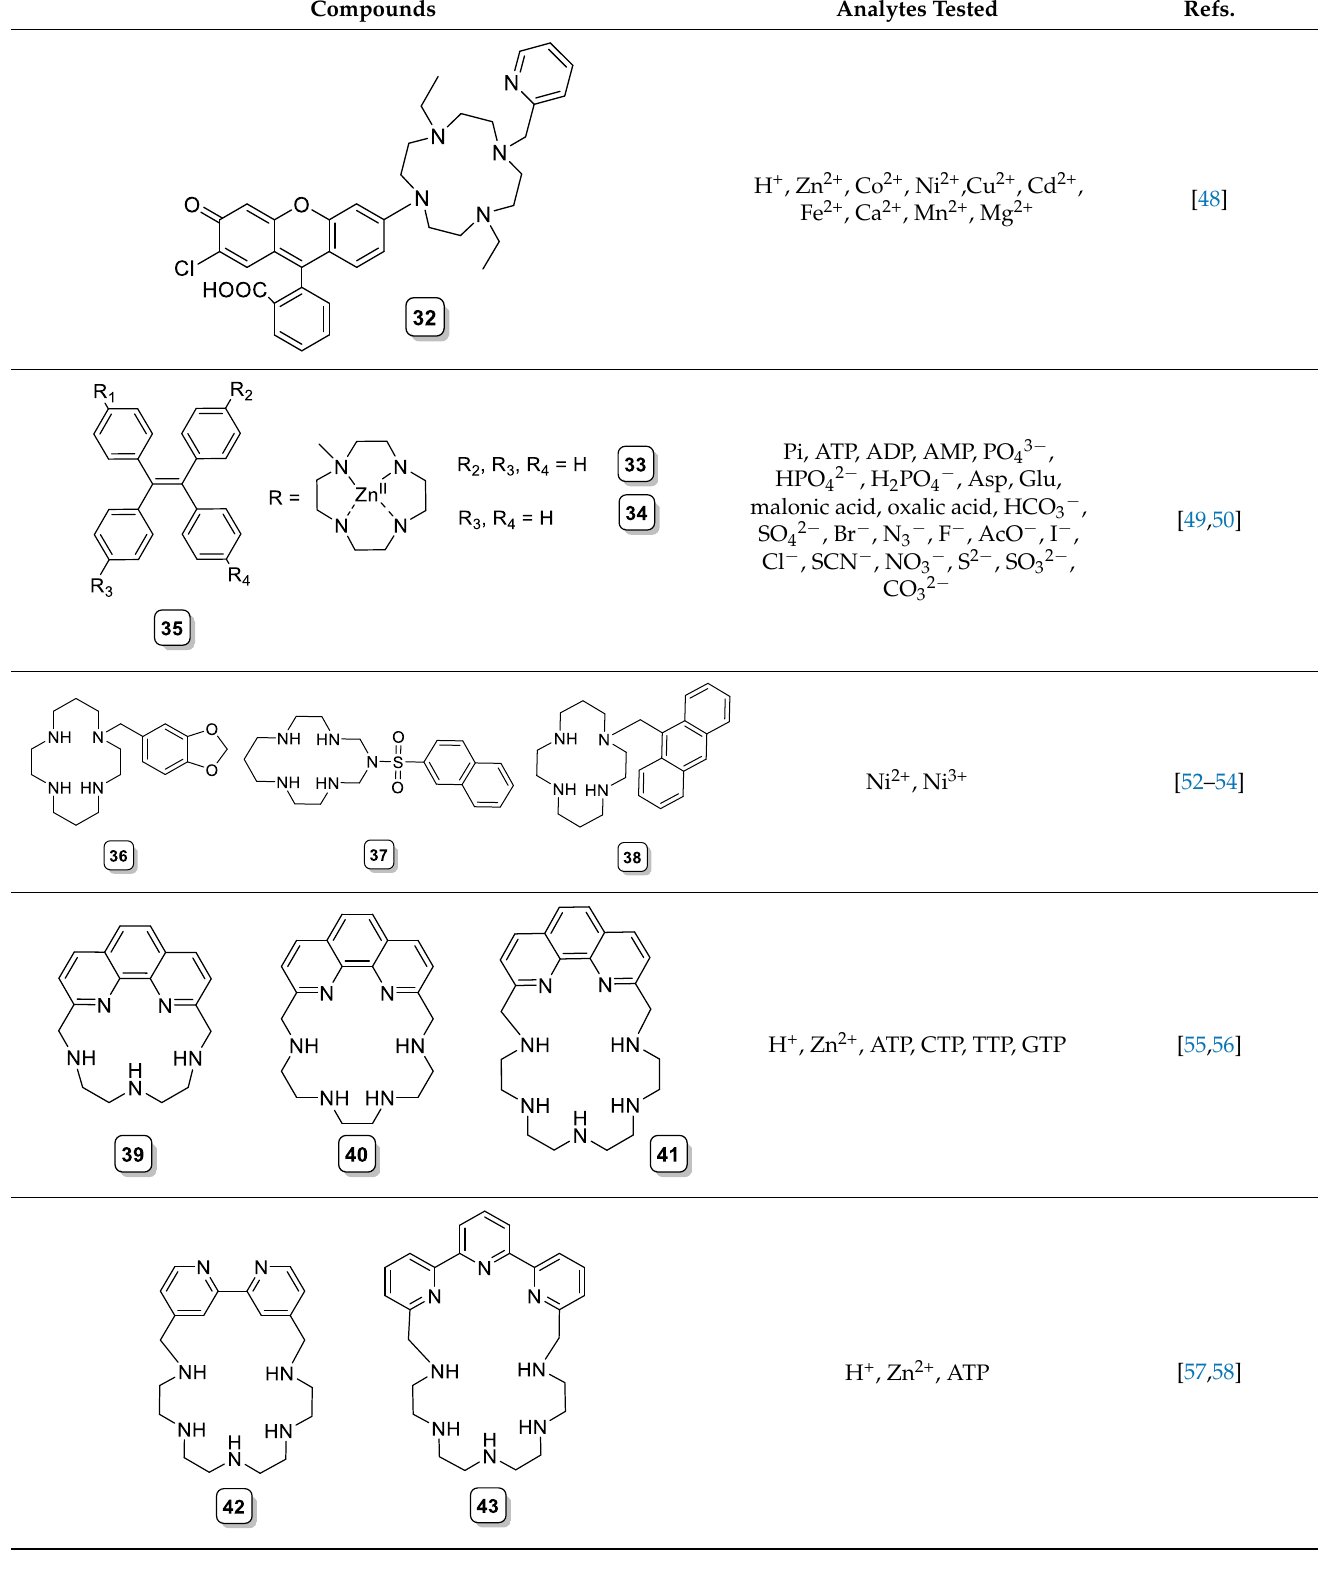
Table A1. Cont. Compounds Analytes Tested